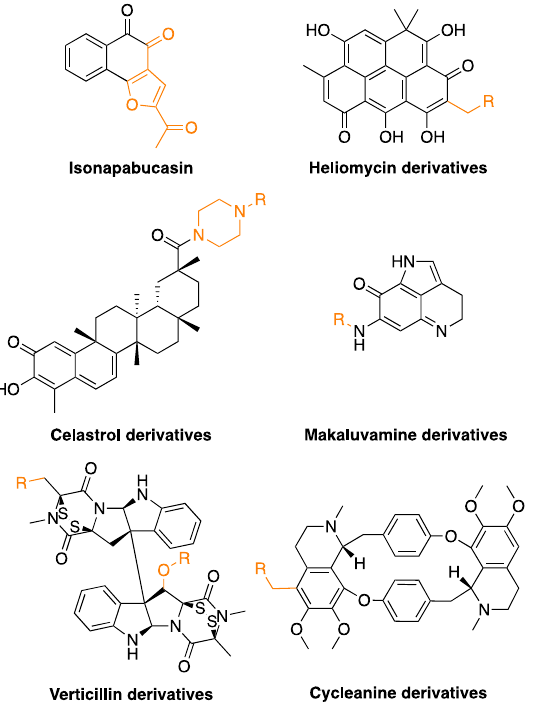
Figure 7. Chemical structures of the discussed semi ‐ synthetic derivatives of natural compounds. The parts of the molecules that have been modified are highlighted in orange.